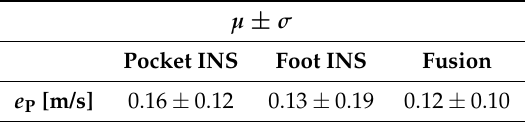
Table 3. Mean ( µ ) and standard deviation ( σ ) of the position error rate of each INS under